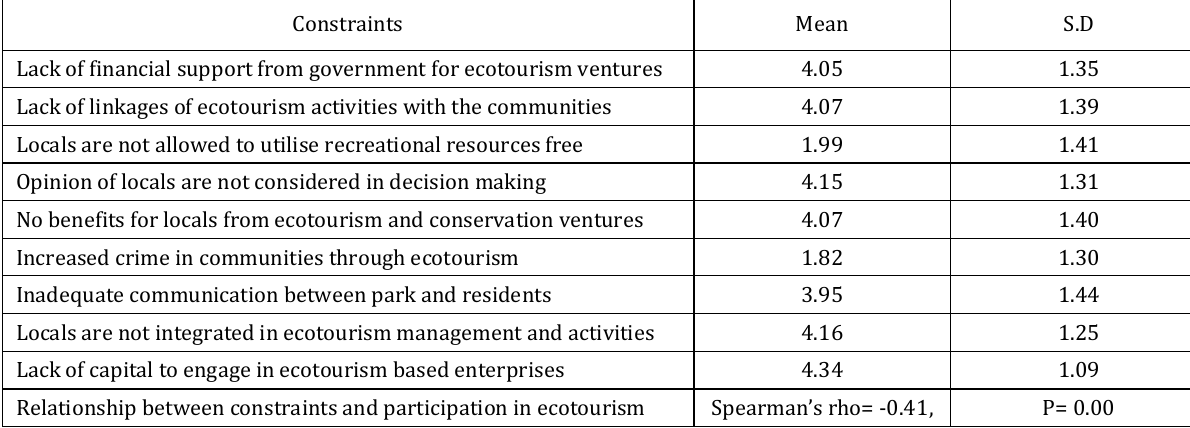
Table 6. Constraints to communities participation in